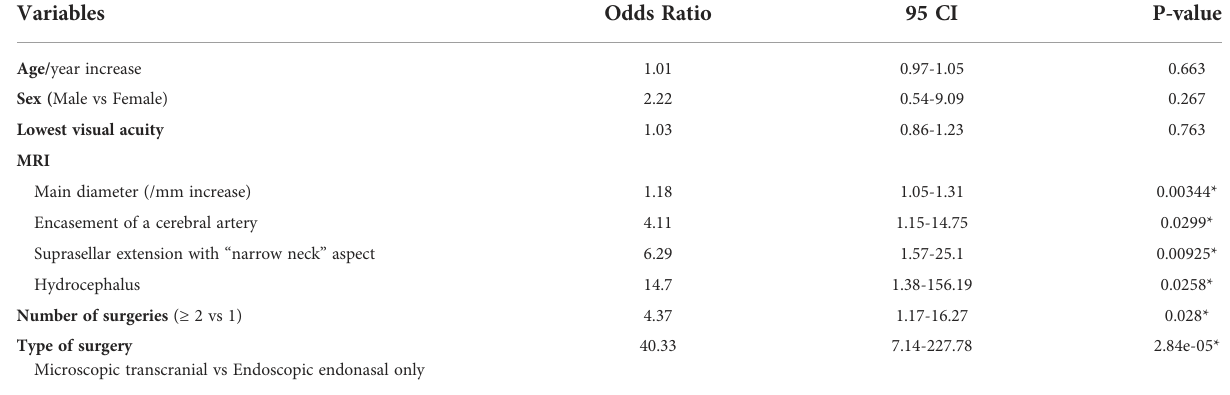
TABLE 4 Logistic regression model predicting surgical complications.